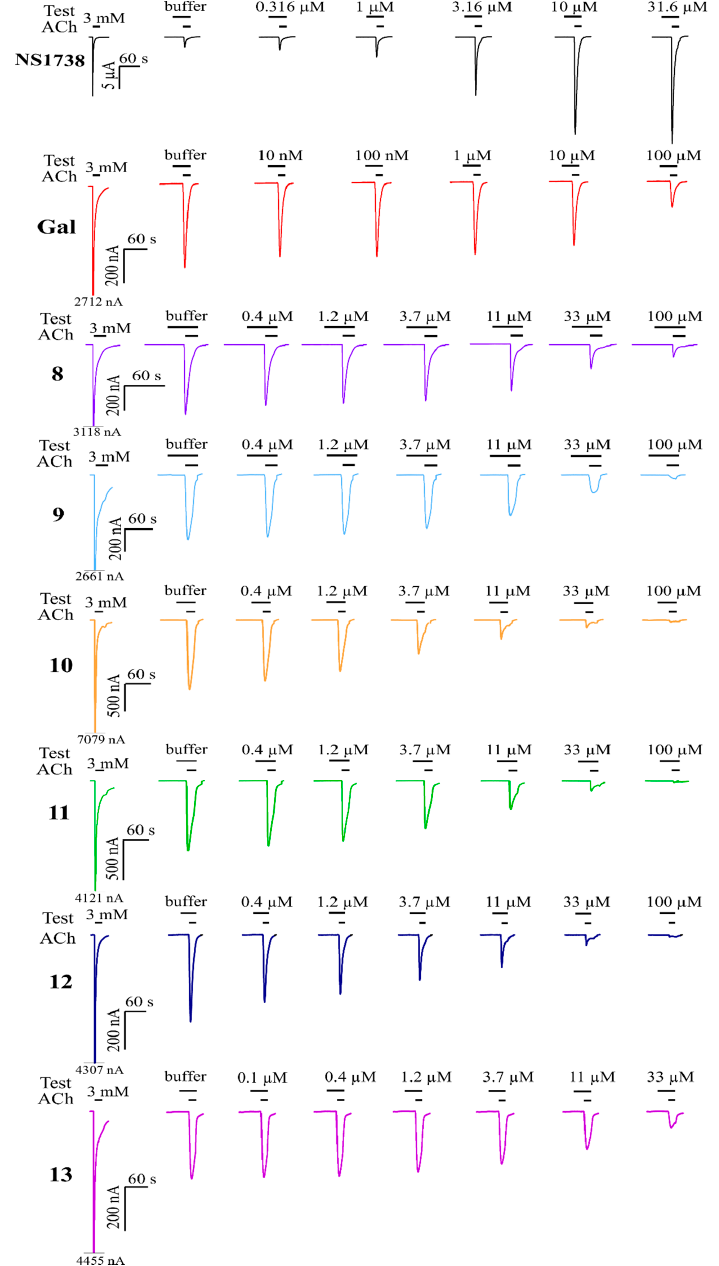
Figure 2. Representative current traces for NS1738, galantamine, and selected compounds from α 7 nAChRs expressed in Xenopus oocytes. Cells were subjected to two-electrode voltage-clamp electrophysiology experiments; the oocyte membrane potential was clamped at − 60 mV. All experiments involved a pre-incubation protocol that consisted of 25 s application of the test solution (or a saline solution for the reference trace) followed by 20 s co-application with 30 µM ACh. The representative traces were baseline subtracted, and the bars above each trace represent the application periods, and concentrations of the test solutions appear above the bars. The majority of the washing periods (3 min) between each trace are omitted.